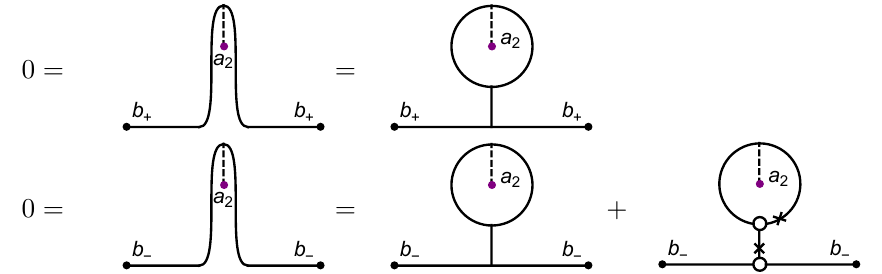
Figure 55 . Lassoing the defect operator a 2 2 H X . The (cid:12)rst diagram vanishes by modular invari- ance of the torus one point function of a 2 attached to a spatial Y loop via an XY Y junction. The second diagram vanishes as a consequence of the crossing phase e K Y;X ( Y; Y ) = (cid:0) 1. The third and X;Y last diagrams can be shown to have vanishing correlators with the defect operators b (cid:6) 2 H Y using crossing and the previous vanishing results (see (cid:12)gure 56). Similar arguments ensure that the (cid:12)rst two lasso diagrams for a 1 also vanish (but not the last two).